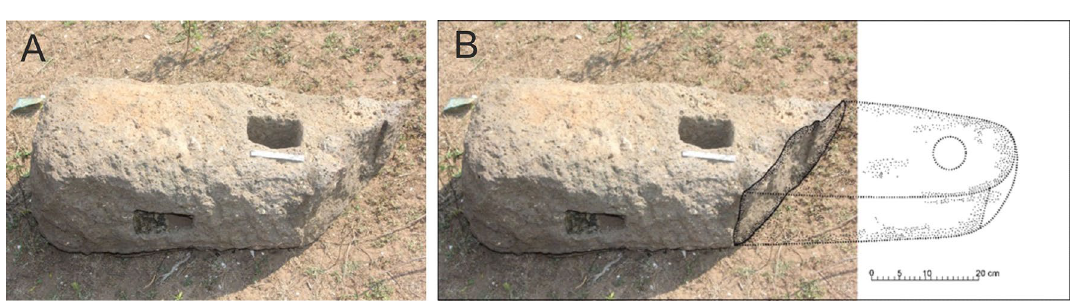
Figure 3. ( A ) Indo-Arabian broken stone anchor found at Manikapatna on Chilika Lake, Odisha; ( B ) Likely outline of the original anchor, reconstructed based on similar anchors found elsewhere 12 .